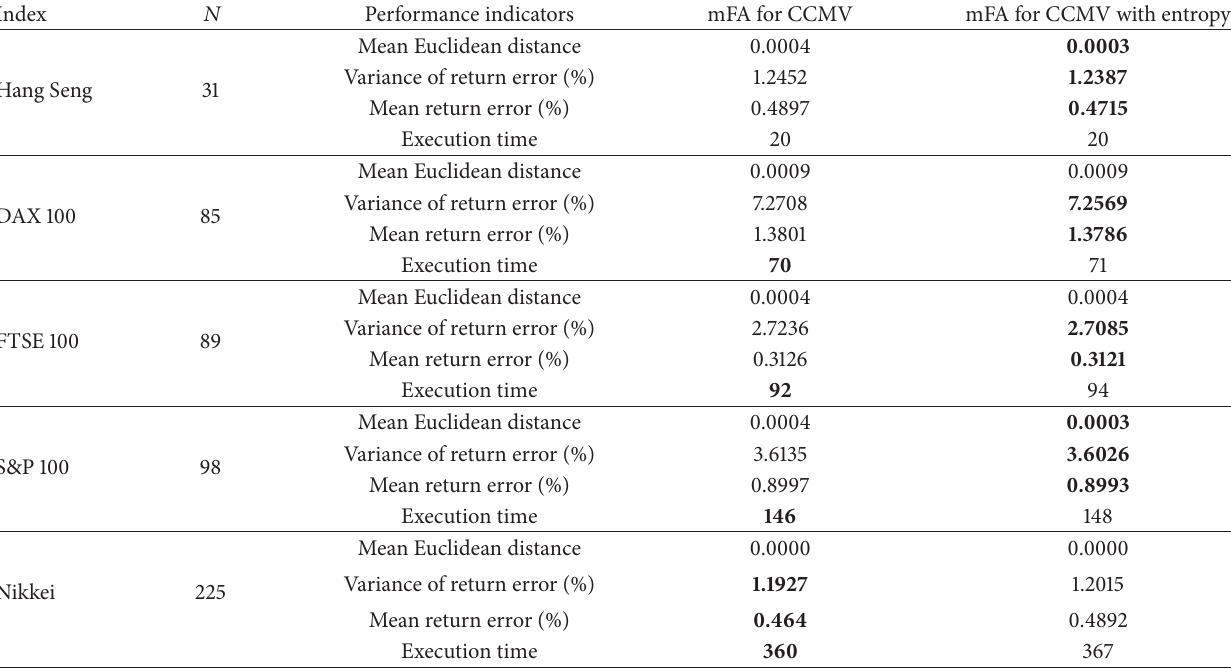
Table 4: Experimental results of mFA for CCMV model with and without entropy